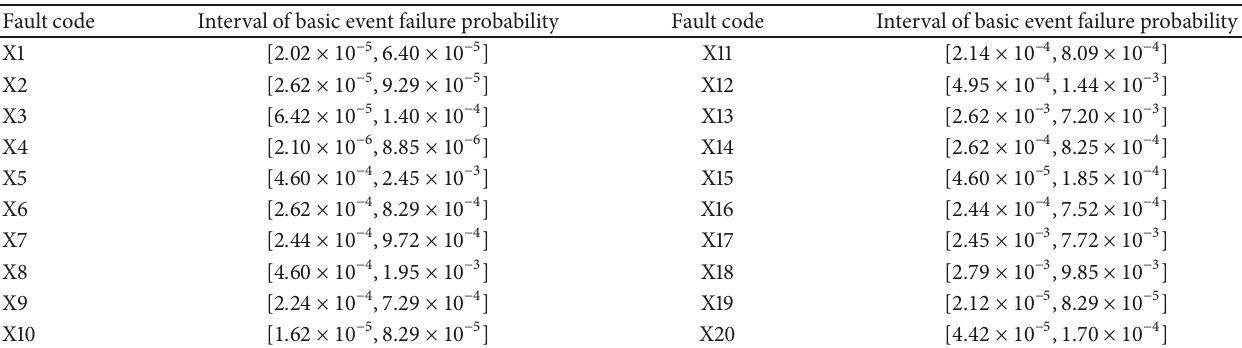
Table 1: Interval of basic event failure probability in the landing gear retraction system fault tree. Fault